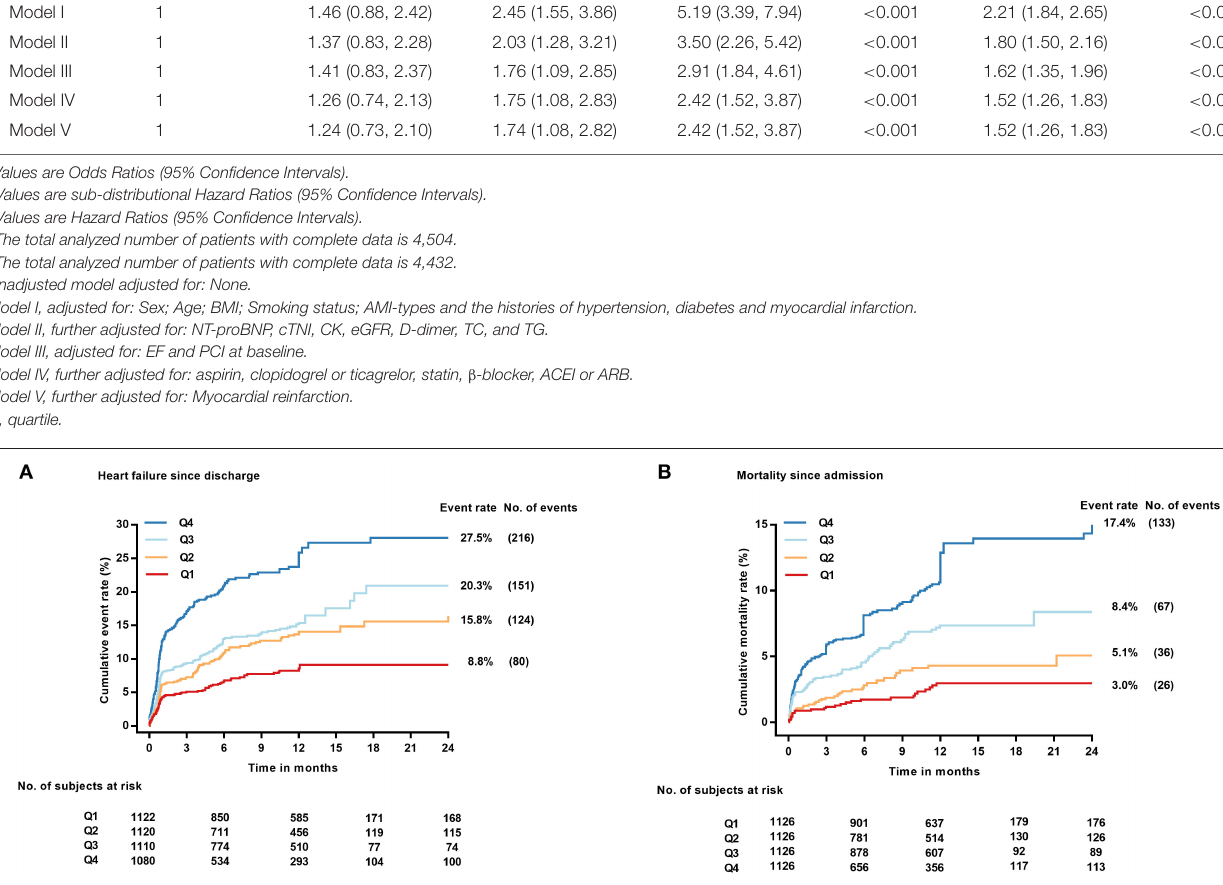
FIGURE 3 | Cumulative incidence of HF post-discharge treating death without HF as competing risk (A) and Kaplan–Meier plot of all-cause mortality (B) across hs-CRP quartiles. No., number.